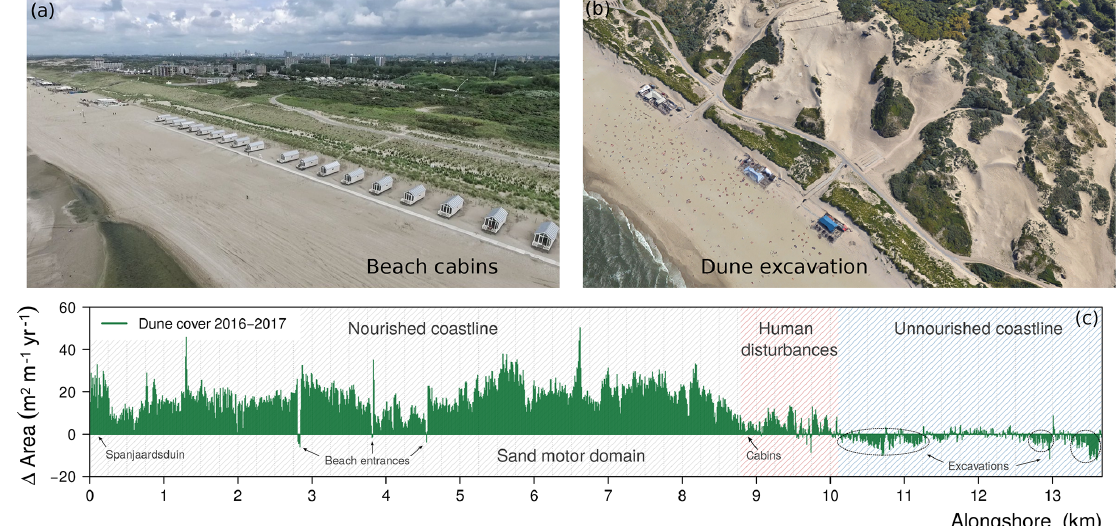
Figure 9. Overview of total alongshore changes in dune cover by marram grass between 2016 and 2017 (in m 2 m − 1 yr − 1 ) in relation to anthropogenic activities that impact (positively and negatively) dune development along the Delfland coast. Aerial photographs courtesy of René Oudshoorn (a) and Google Maps (b)